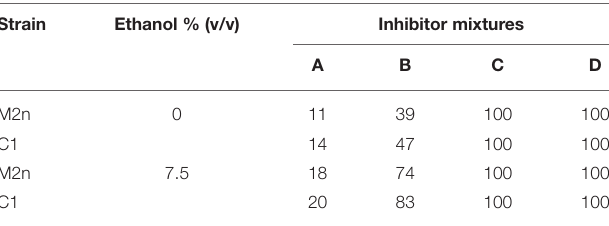
TABLE 3 | Mortality (%) induced by four concentrations of inhibitors mixture with or without 7.5% ethanol.